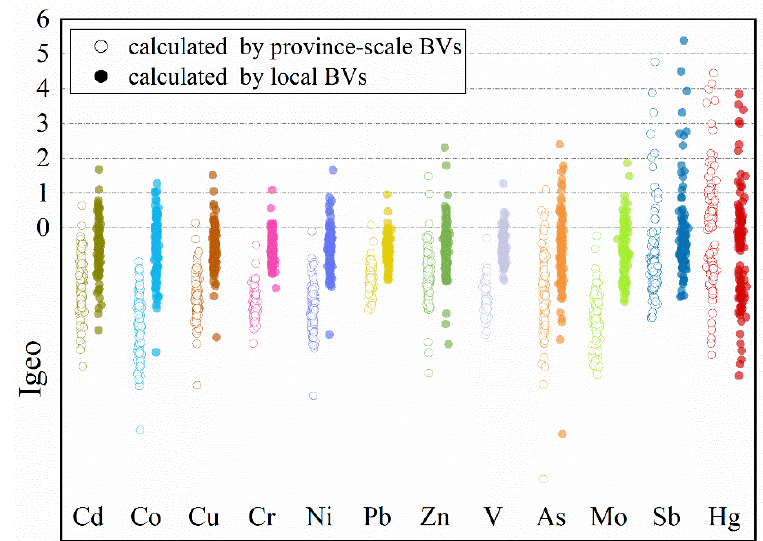
Figure 2. Levels of PTE contamination classified by I geo in the Caidi River Watershed. Each group of open circles or closed circles represents the geo-accumulation index ( I geo ) of one PTE: Cd (bronze green), Co (baby blue), Cu (brown), Cr (pink), Ni (pale blue), Pb (yellow), Zn (vivid green), V (mauve), As (orange), Mo (grass green), Sb (royal blue) and Hg (red). The open circles and closed circles represent the geo-accumulation indexes calculated based on province-scale BVs and local BVs, respectively.